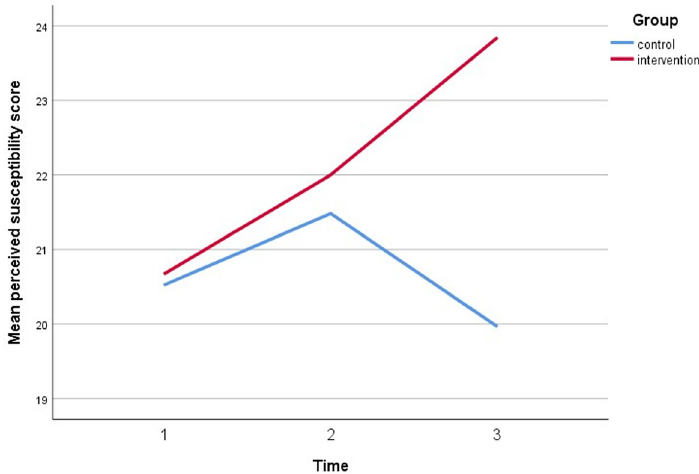
Fig 5. The plot of perceived susceptibility scores among respondents showing an interaction.